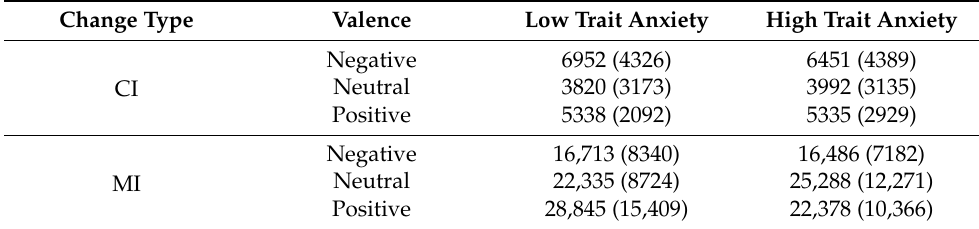
Table 3. Performance (RTs mean and standard deviation) in the emotional flicker task considering the emotional valence of the stimuli and the type of change in individuals with low and high trait anxiety.